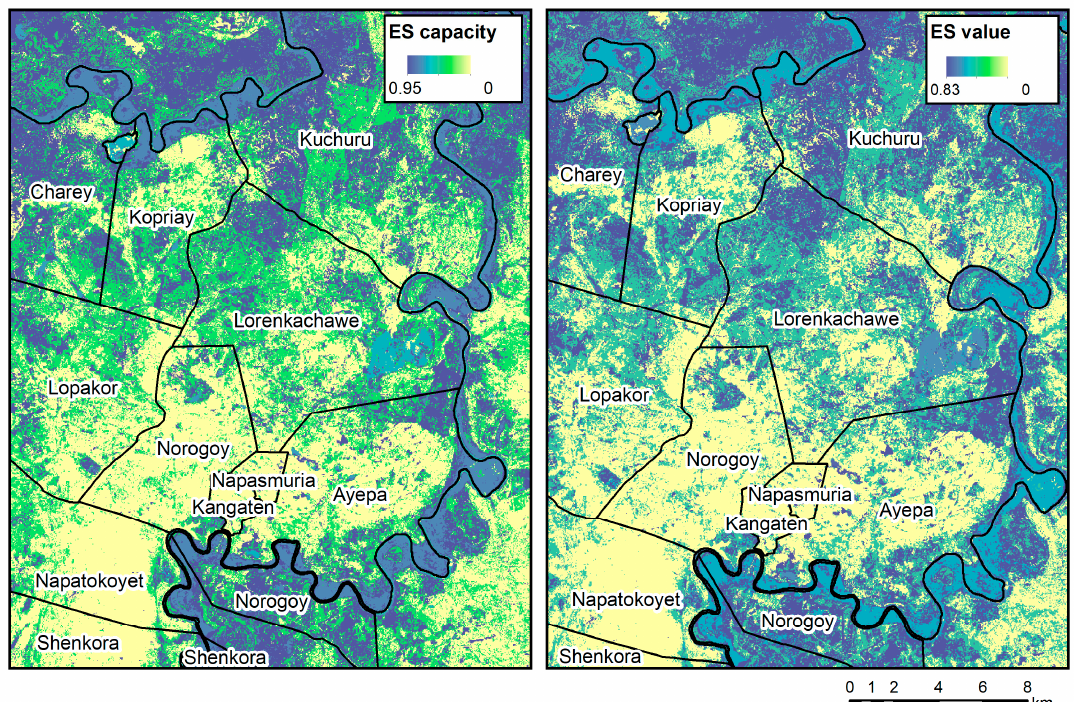
Figure 6. Provisioning Ecosystem Service (ES) capacity and ES value during 2016–2019 for kebeles in Nyangatom, South Omo Zone, Ethiopia. Capacity and value metrics for each land use category (Table 6) were derived from the participatory mapping and then integrated with remote sensing data to show the spatial distribution of ES.